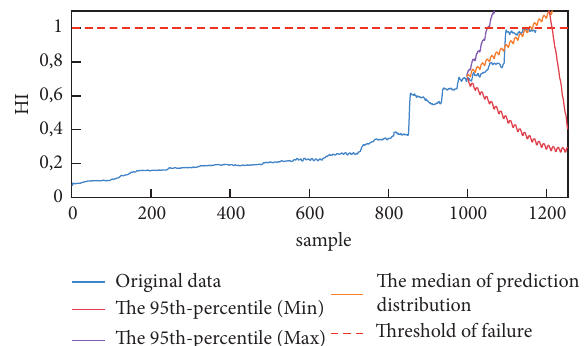
Figure 11: ARIMA-based prediction results for sample 1